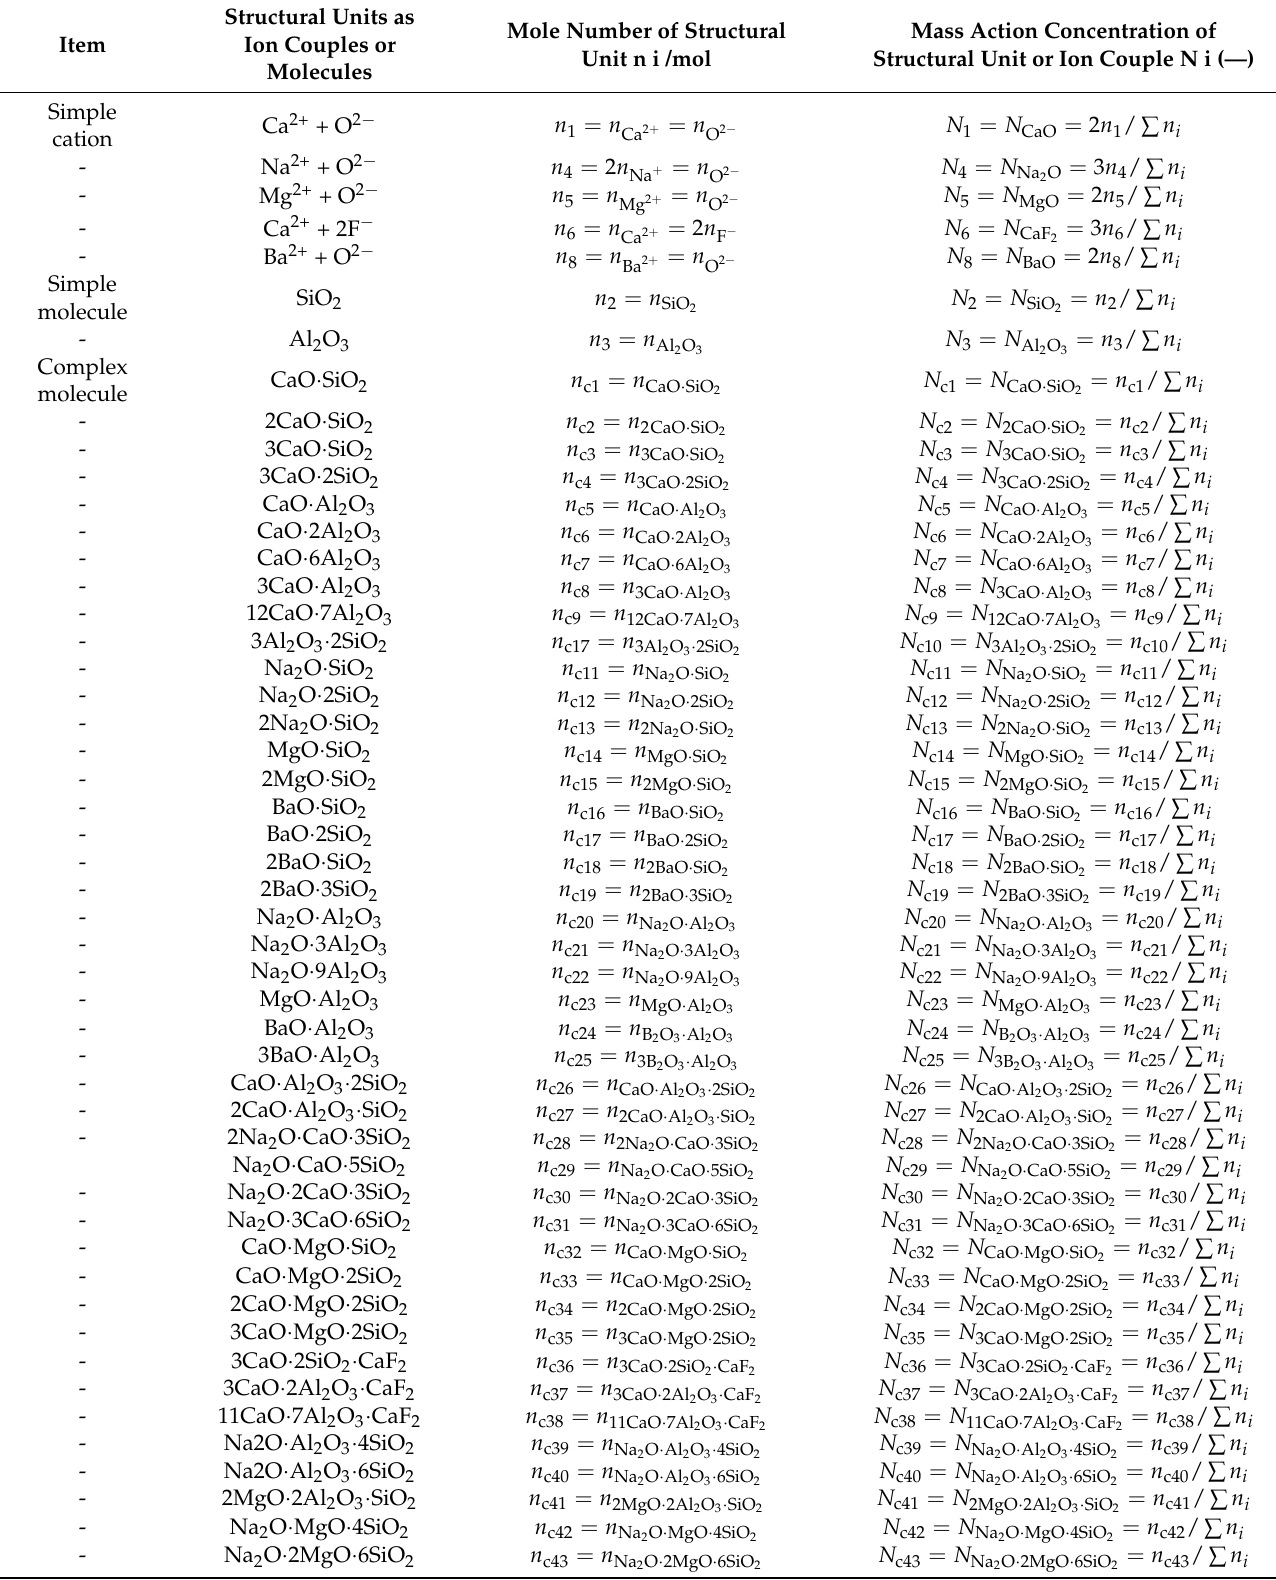
Table 2. Expression of structural units as ion couples or complex molecules, their mole numbers, and their mass action concentrations in 100 g of CaO-SiO 2 -Al 2 O 3 -Na 2 O-MgO-CaF 2 -BaO slags based on IMCT. Mole Number of Structural Mass Action Concentration of Item Structural Unit or Ion Couple N i